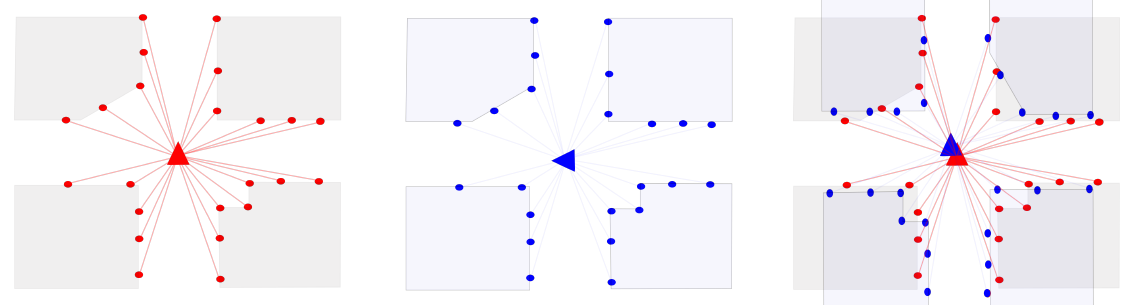
Figure 4. Local minima situation caused by a significant change of the angle of